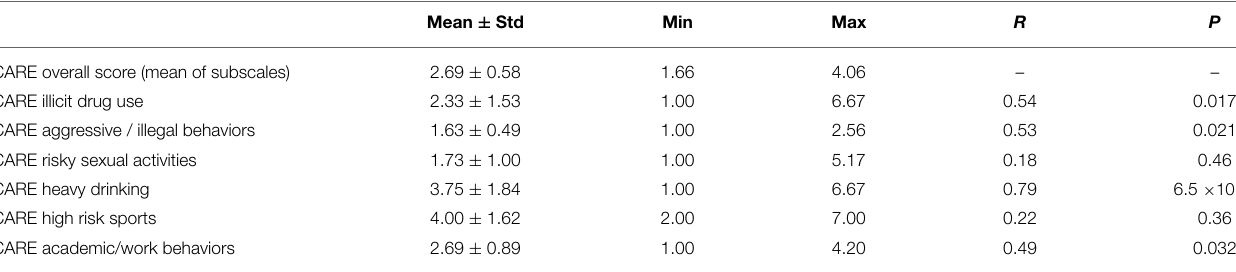
TABLE 1 | Summary of CARE scores and subscale scores.